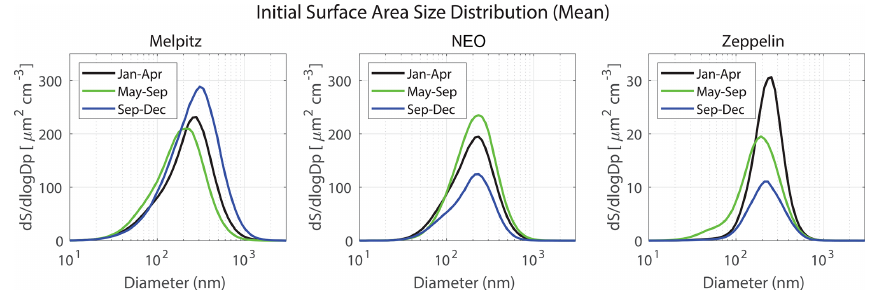
Figure 11. Surface area size distribution for measured ambient aerosol used to initiate each trajectory. Mean distributions for spring (January– April), summer (May–September) and autumn (September–December) for Melpitz, NEO and Zeppelin. The division into these time periods is taken from to emphasize differences between different periods. Note that the y axes have different scales for the different